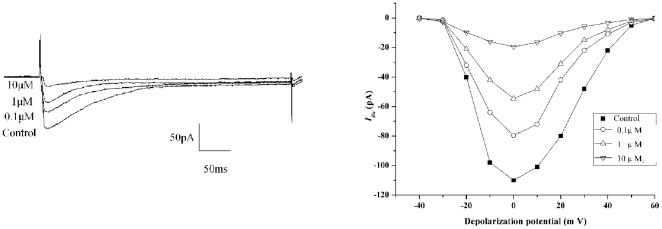
Effect of 16c on L-type Ca2+ channel currents in vascular smooth muscle cells (A) and on I–V relation of Ba2+ currents in vascular smooth muscle cells (B).The step protocol of recording was described in methods section.